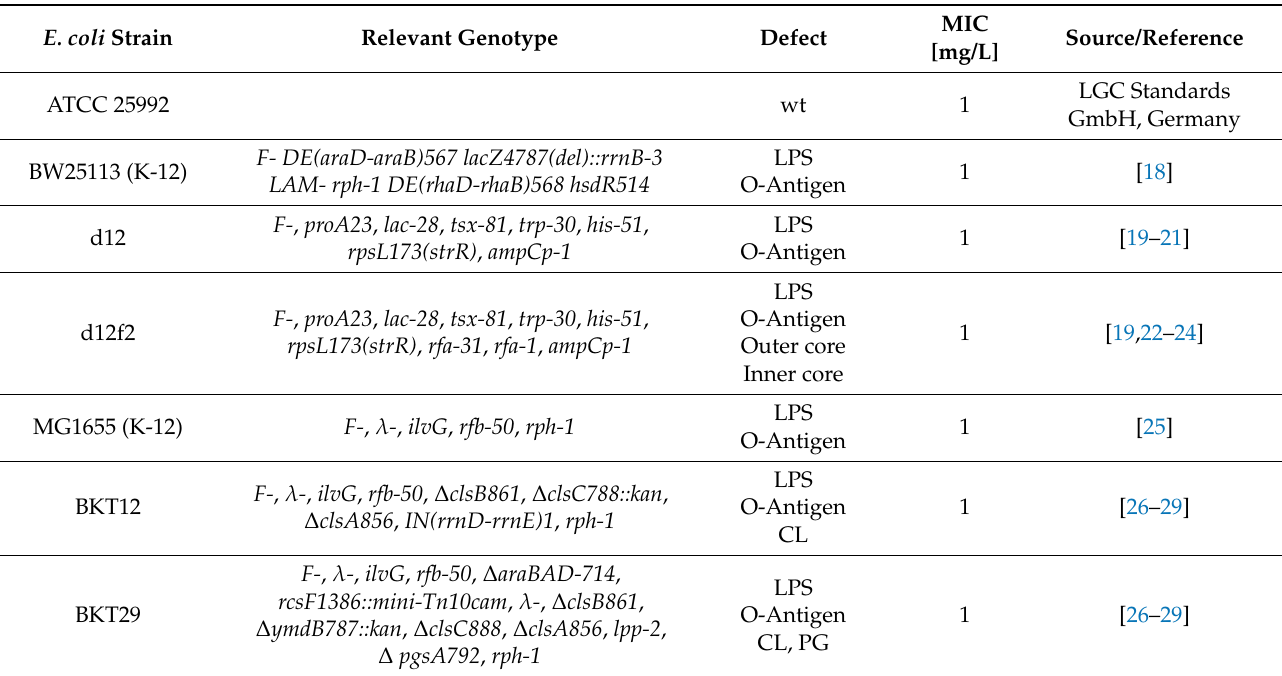
Table 1. Characteristic of used E. coli strains including MIC values for OCT. Minimal inhibitory concentration (MIC) was determined for 1 × 10 6 CFU/mL (colony forming units/mL) where no visible growth was observed at 420–580 nm in the presence of